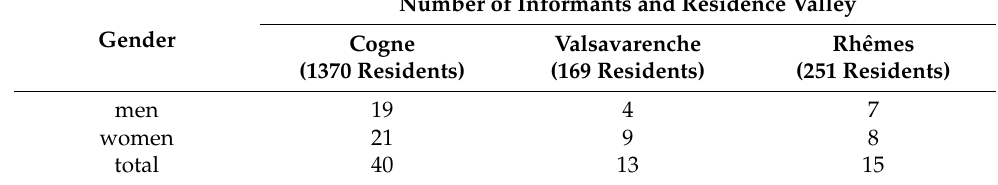
Table 1. Distribution of the informants, gender and residence in the municipalities of Cogne (1.544